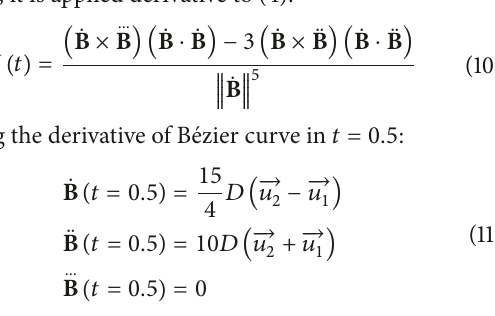
20 degrees to 145